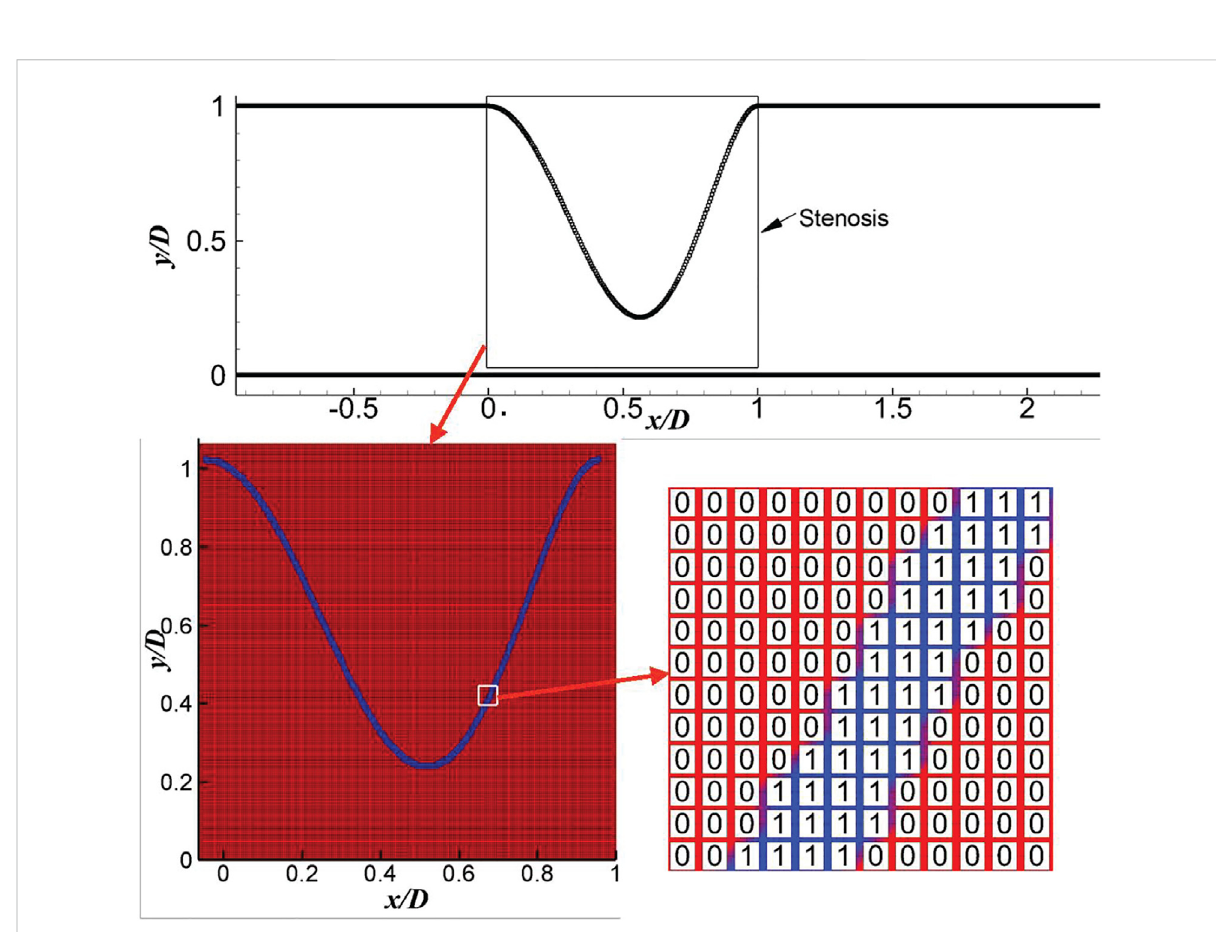
FIGURE 2 An example of image generation for the input of the 2D